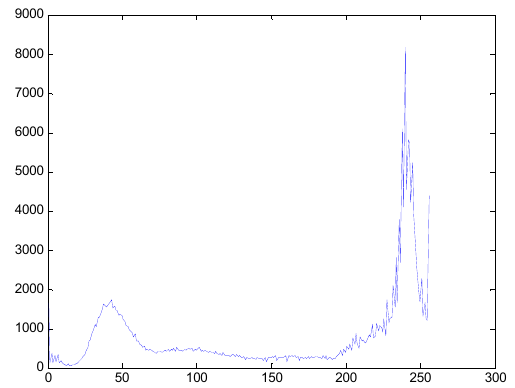
Figure 3. The histogram of the B signals in the entire image. Sensors 2016 , 16 , 1590